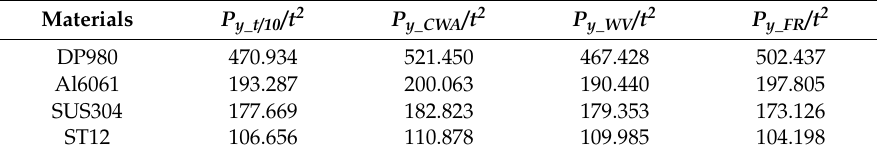
Table 4. Yield load of experimental materials identified by di ff erent identification methods.